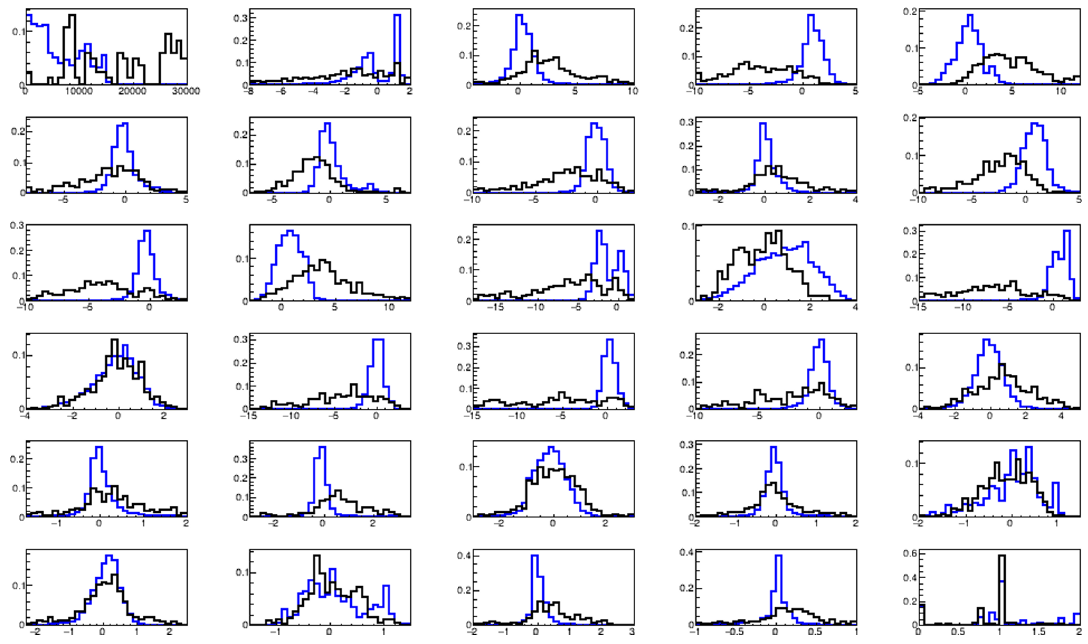
fraudulent transactions are shown in black, and regular ones are shown in blue.